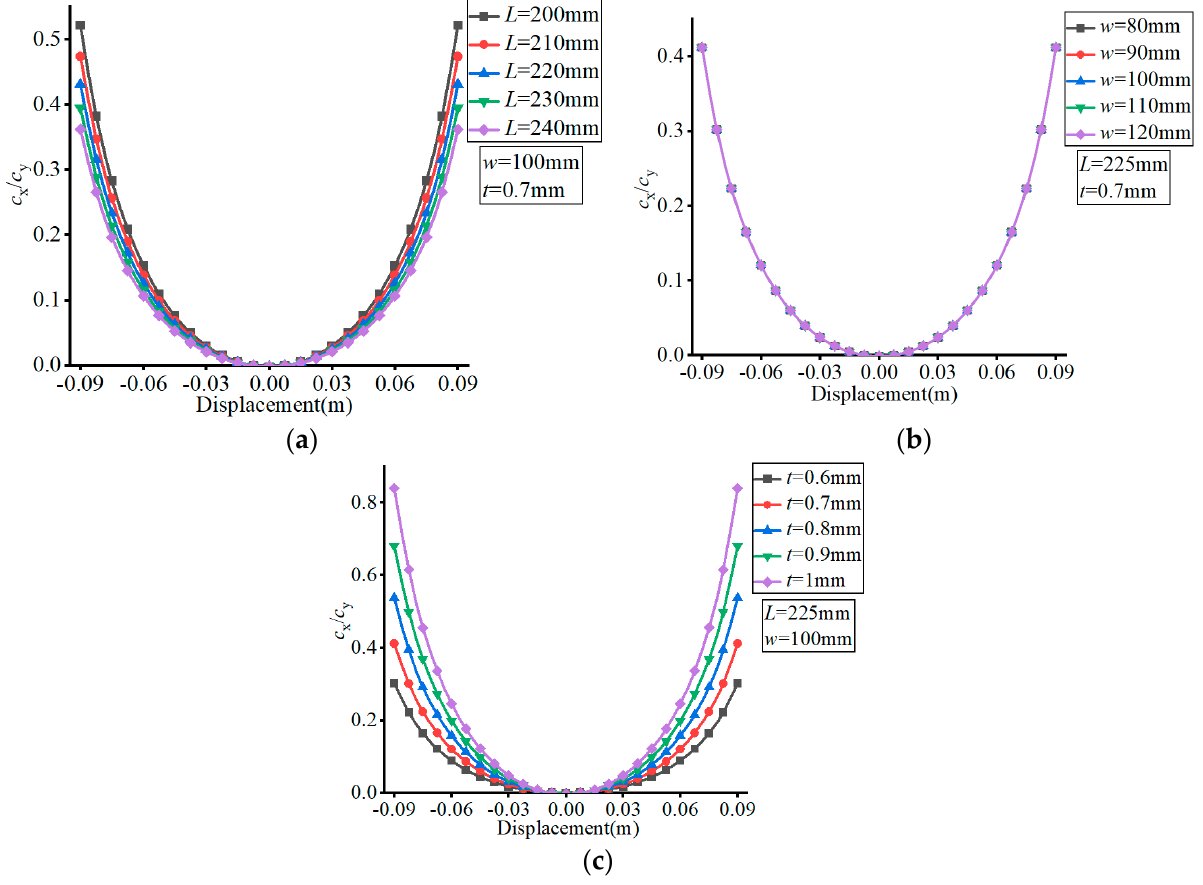
Figure 10. Effect of structural parameters on c x / c y . ( a ) Effect of L ; ( b ) Effect of w ; ( c ) Effect of t .